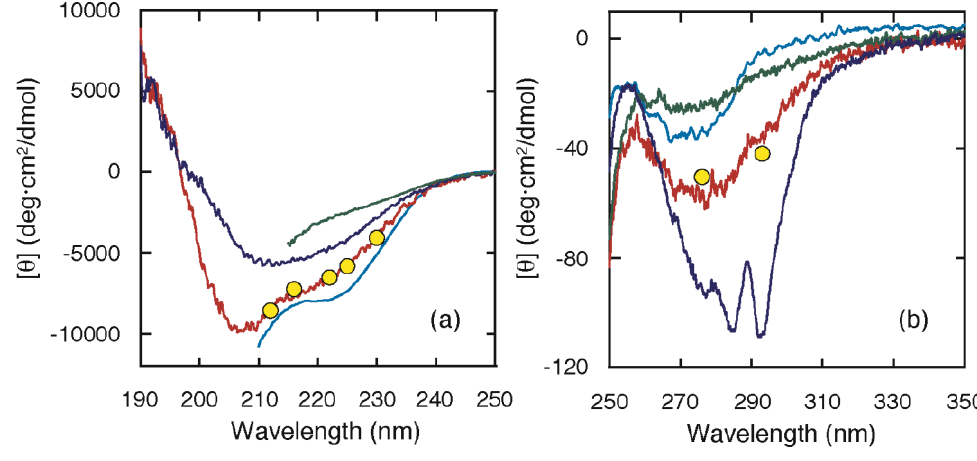
Figure 2. Circular dichroism (CD) spectra of the N, A, C, and U states, and the burst-phase CD values in far (a) and near (b) UV regions. The spectra of the N (blue) and A (red) states were acquired at pH 7.0 and 1.5, respectively, and at 25 °C [20]. The spectrum of the C state (cyan) was measured in the presence of 2 M urea at pH 4.0 and –10 °C [21]. The spectrum of the U state (green) was measured in the presence of 8 M urea at pH 4.0 and 25 °C. The CD values attained within the burst phase of the folding kinetics at pH 4.0 and 25 °C are shown by yellow circles